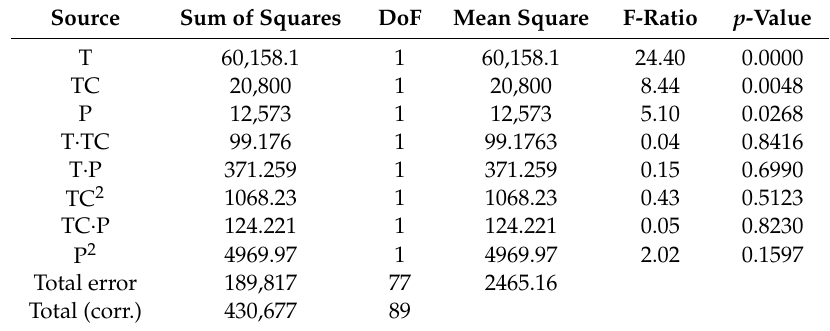
Table 11. ANOVA for estimating elastic modulus of rice husk and pine sawdust